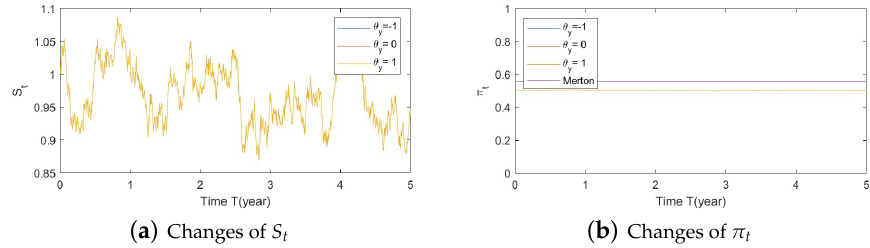
Figure A26. Illustrate the impact on ( a ) stock prices and ( b ) optimal stock allocations when varying θ y ( e . g ., θ y = − 1,0,1 ) .